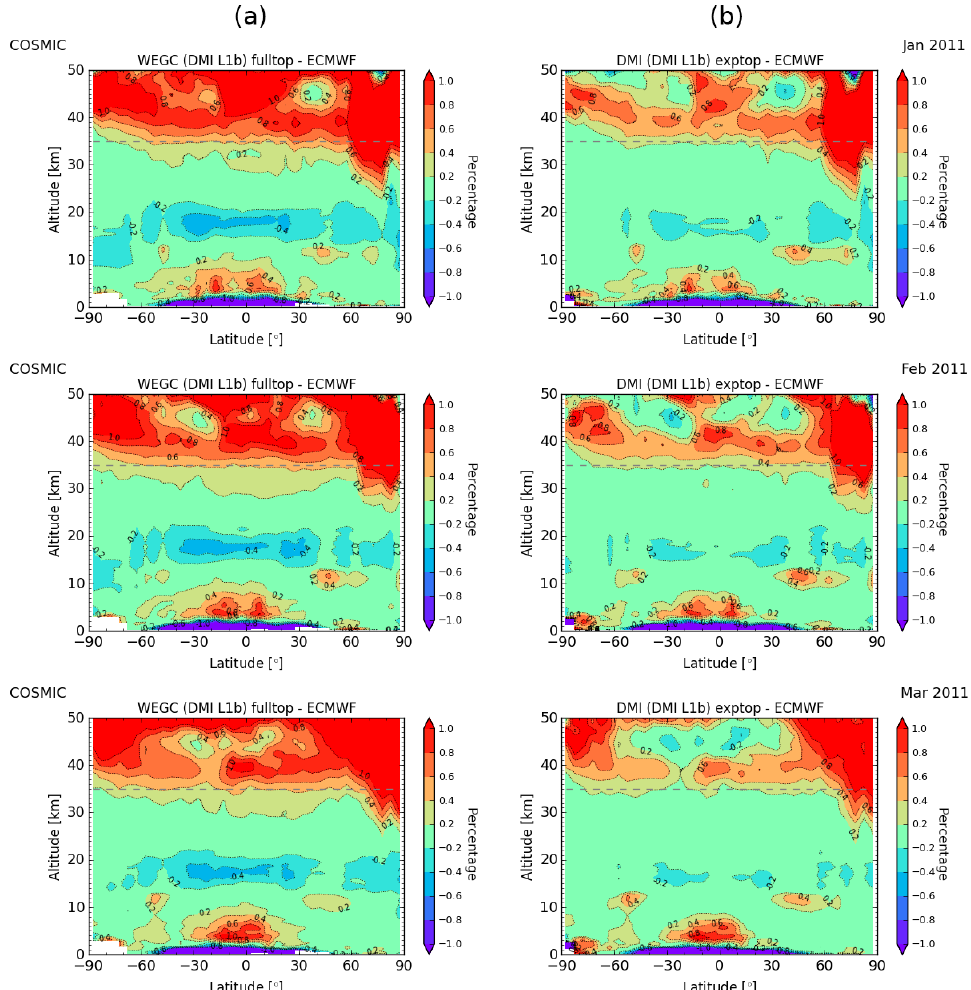
Figure 5. API refractivity climatologies relative to ECMWF analyses, comparing WEGC processing (a) to DMI processing (b) , from January to March 2011, using the same bending angle profiles as input (DMI